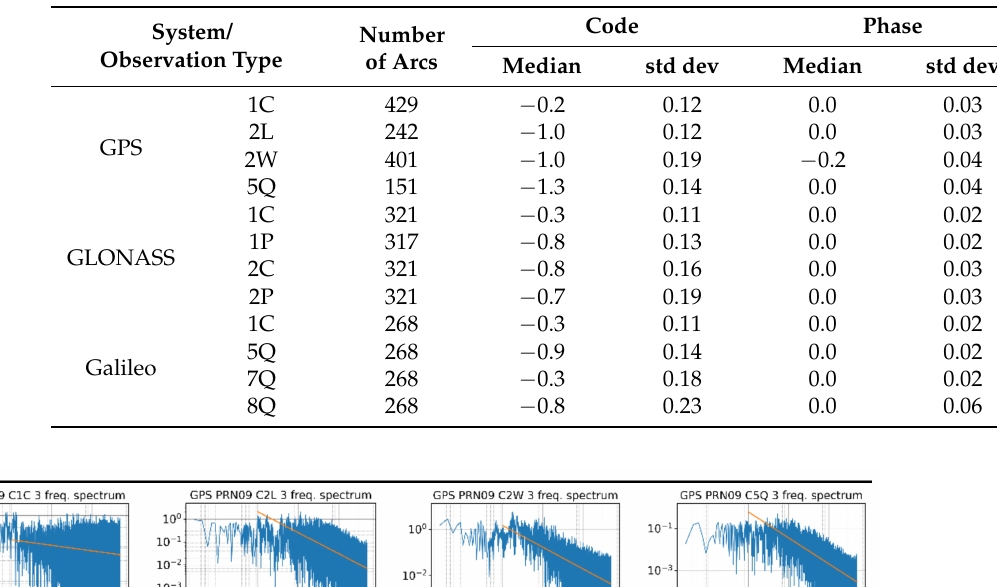
Table 4. Spectral index statistics for analyzed GNSS systems.